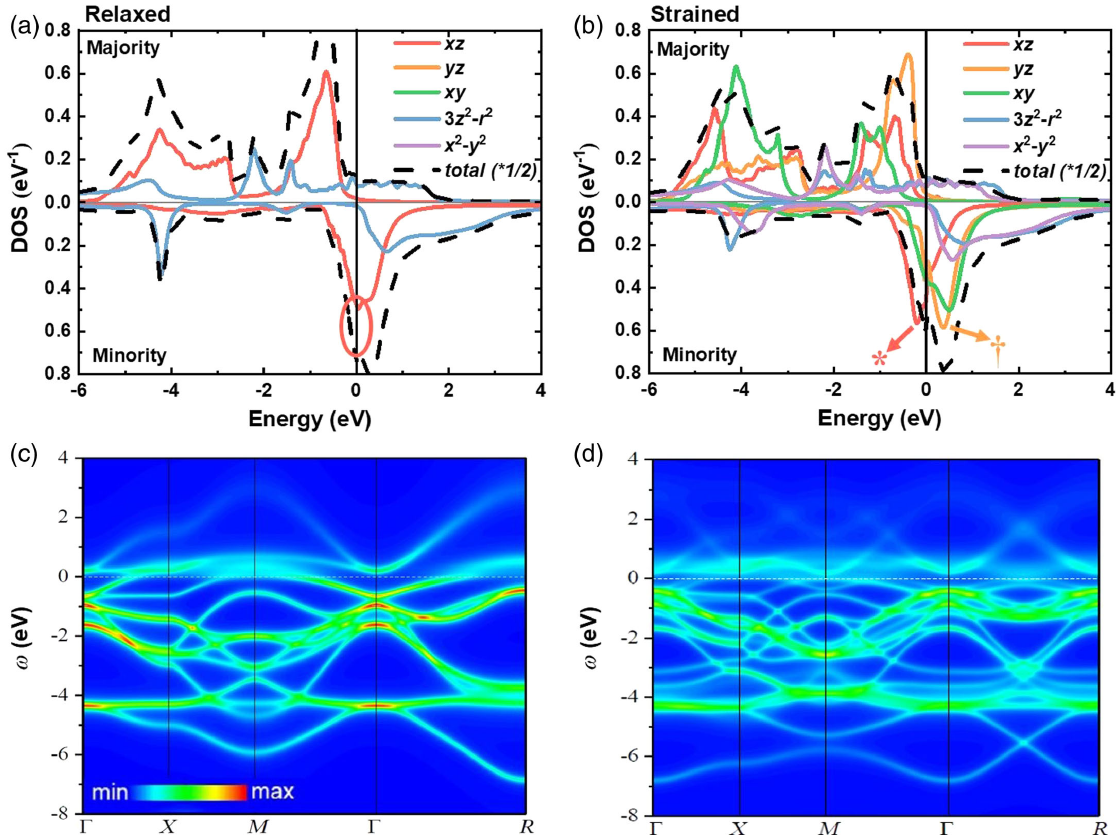
FIG. 4. Evolution of the electronic band structures for strained SrCoO 3 thin films with DFT þ DMFT. Spin-resolved projected density of states (DOS) spectra for (a) the relaxed SrCoO 3 and (b) the strained SrCoO 3 (4% with xz=yz alternating splitting Δ ε ¼ 0 . 1 eV). The arrows highlight a clear splitting inside minority bands (* for minority xz band and † for minority yz band) at the Fermi level for the strained SrCoO 3 as compared with nonsplitting in relaxed SrCoO 3 marked by a red circle. The suppression of the spectral weight at the Fermi level is more clearly seen by comparing the electronic band dispersion for (c) the relaxed and (d) the strained SrCoO 3